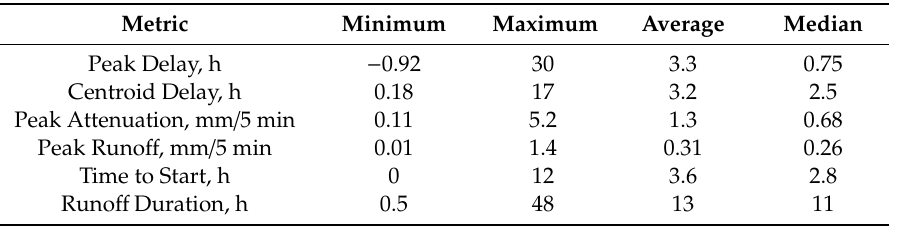
Table 1. Detention metrics for 39 events where runo ff occurred and data are collected at the 5-minute timestep. A visual definition of detention metrics is given in Figure